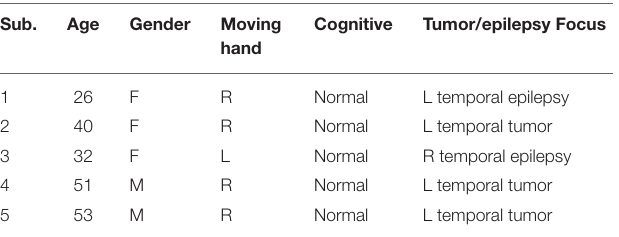
TABLE 1 | Clinical summary of patients enrolled in the study. Sub.